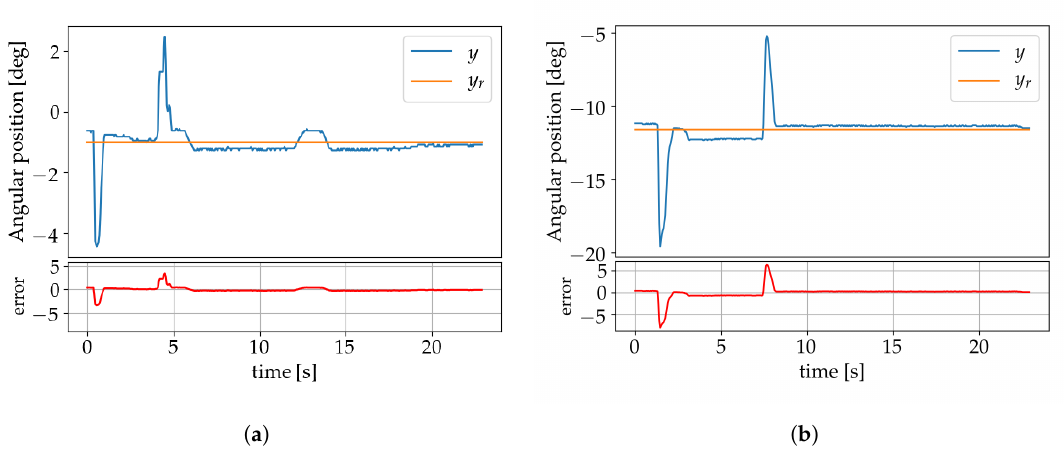
Figure 18. Plots showing the results when applying an extra: ( a ) 85% torque; ( b ) 143%